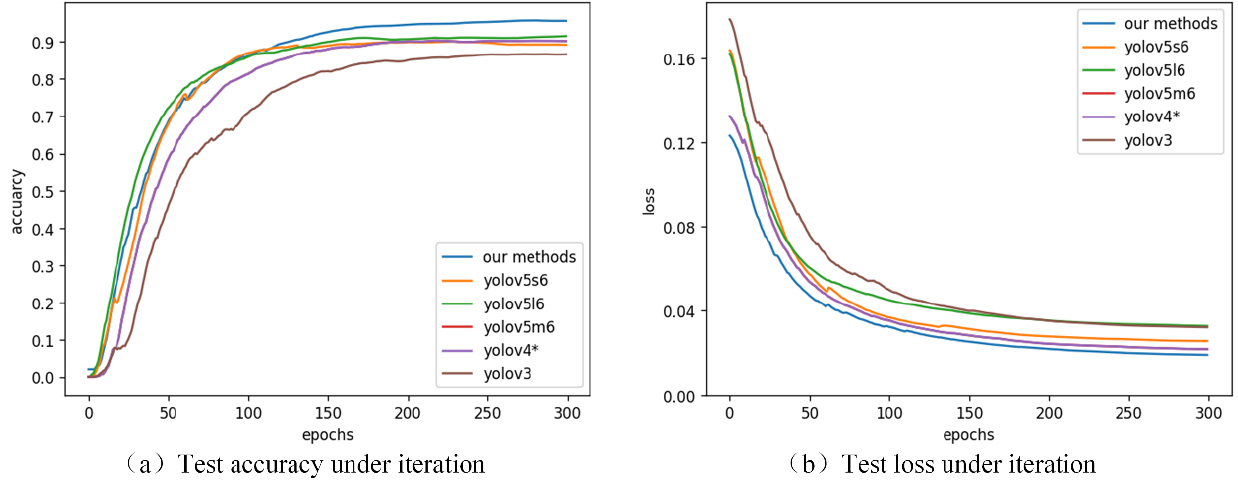
Figure 13. Test accuracy ( a ) and loss ( b ) of the proposed method and some typical two-stage detection algorithms in the DR datasets.